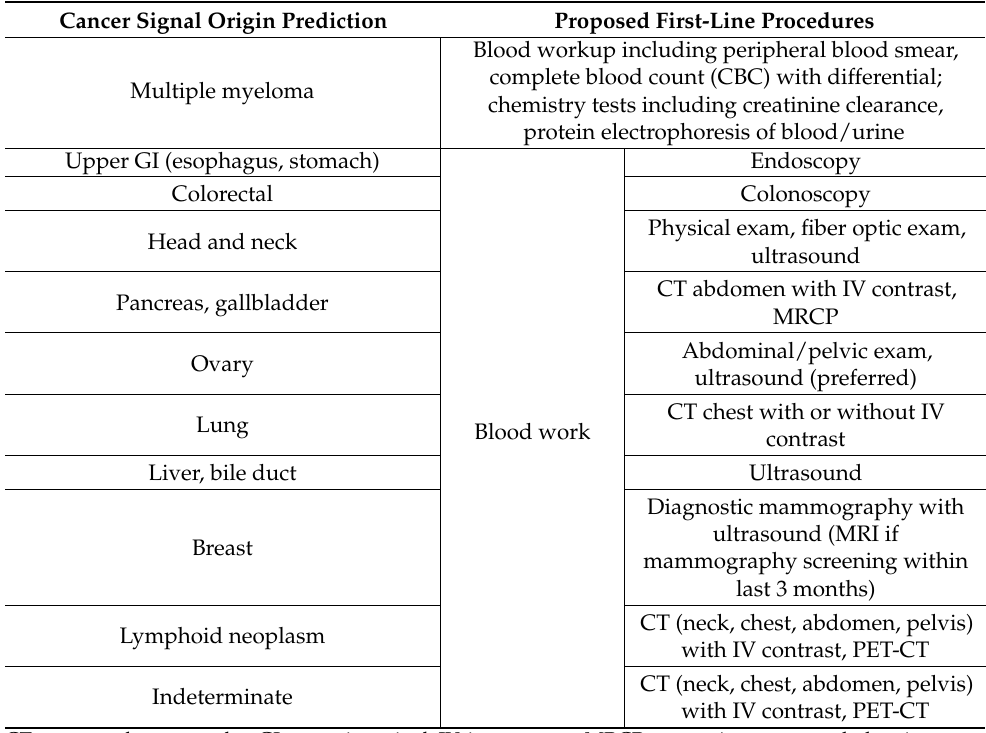
Table 1. Proposed clinical care pathways following a “Signal Detected” test result and cancer signal origin